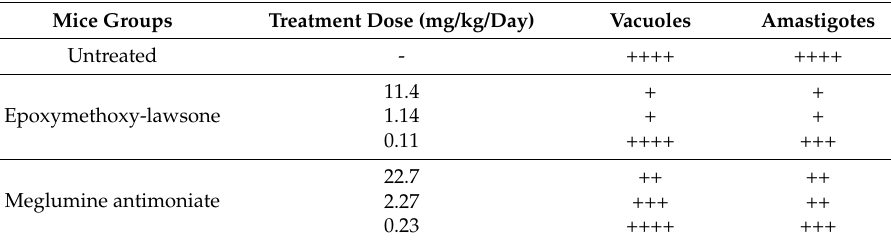
Table 2. Semiquantitative analysis of BALB/c mice skin lesions caused by Leishmania ( L. ) amazonensis.